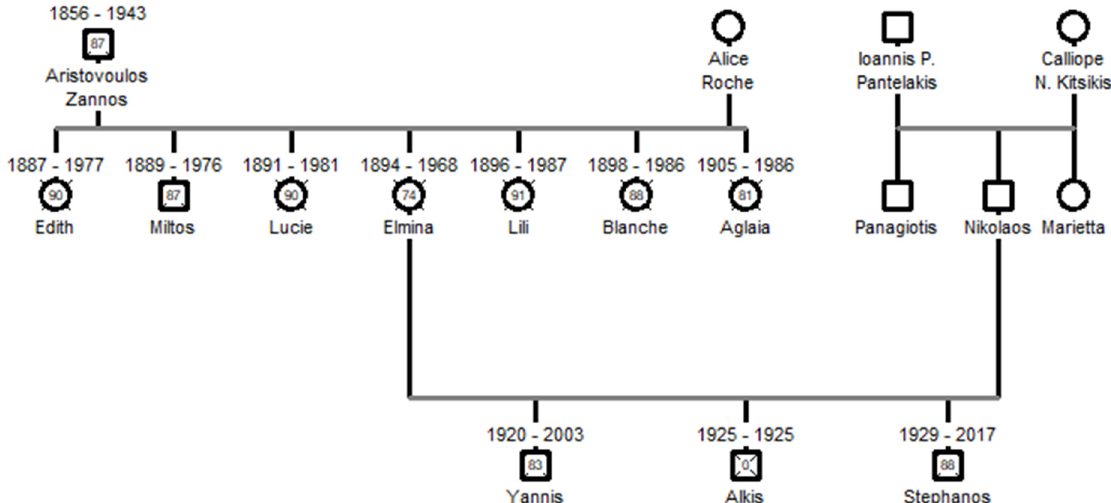
Figure 3. Elmina Zannos’ family tree.